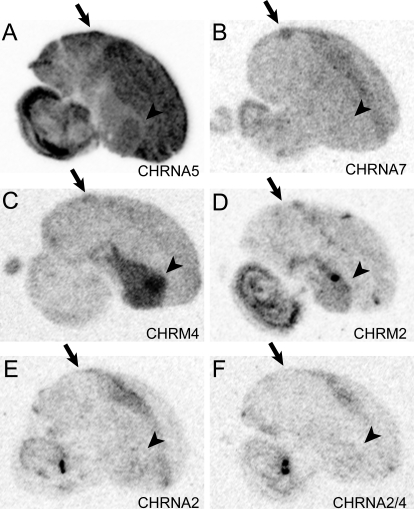
(A–F) Phosphorimage autoradiograms showing the patterns of expression for nicotinic (in A, B and E, F) and muscarinic (in C, D) acetylcholine receptor subunits in sections hybridized with antisense probes direct against various receptor subunits.See text for additional details and gene name abbreviations. Arrows indicate the locations of nucleus HVC in each as identified under bright-field illumination in an adjacent Nissl stained section, arrowheads indicate the location of area X. Scale bar: 1 mm.